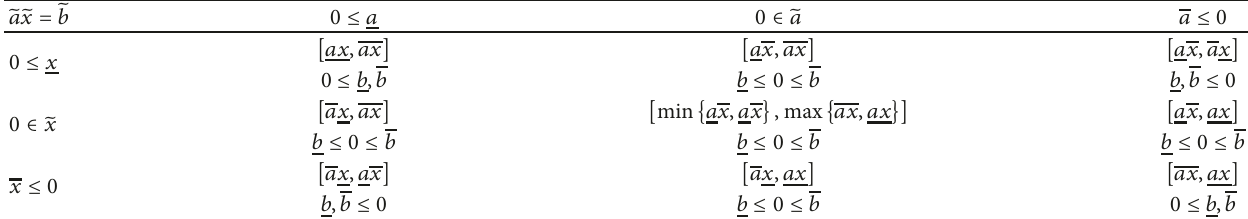
Table 1: Interval multiplication in